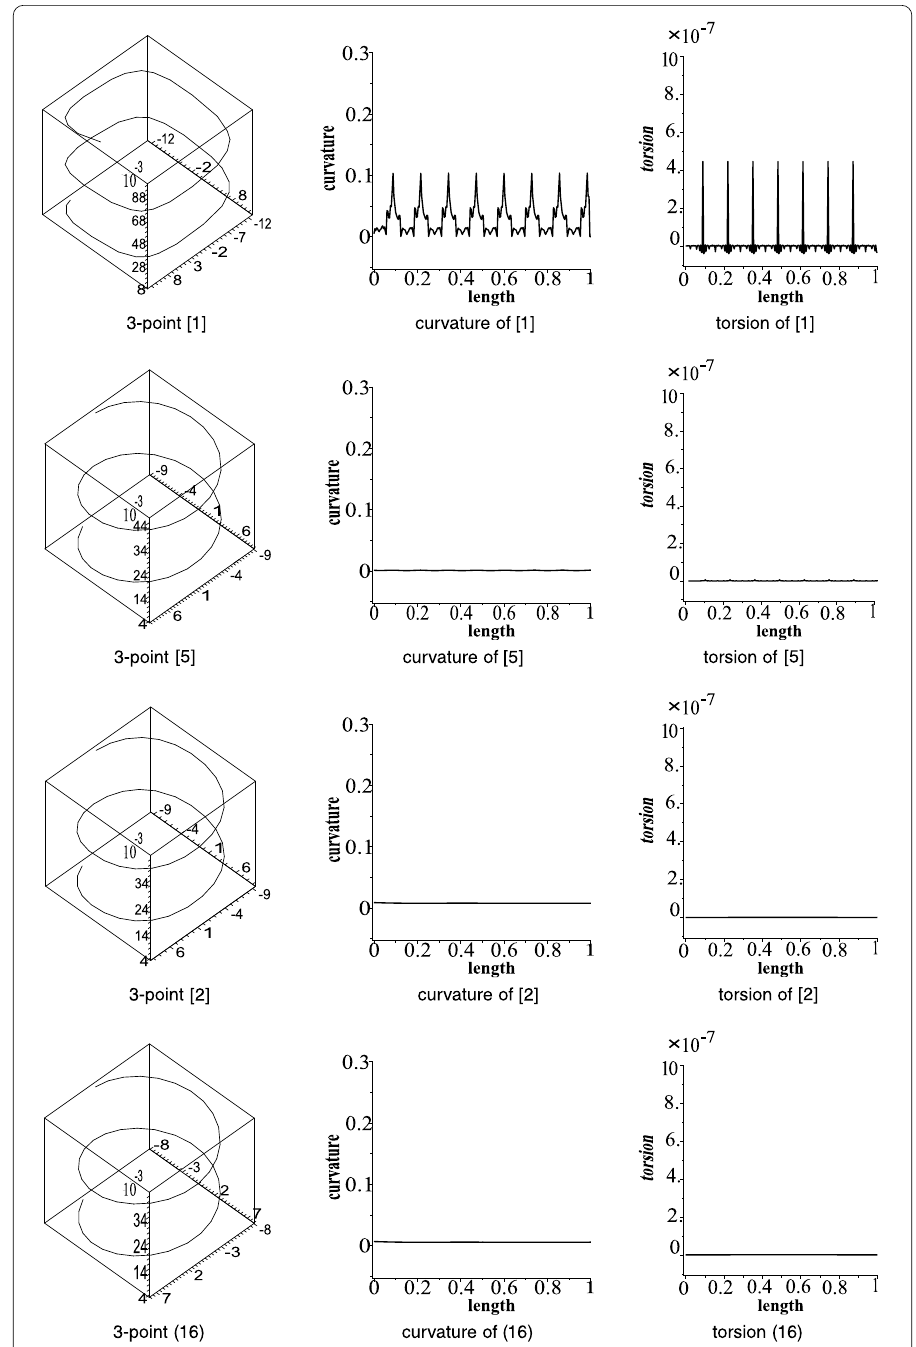
Figure 7 Results after the 5th iteration of 3-point schemes of [5, 6, 13] and (16) are shown on the left when the initial control points are sampled from Helix. The corresponding curvature and torsion are shown in the center and right columns,